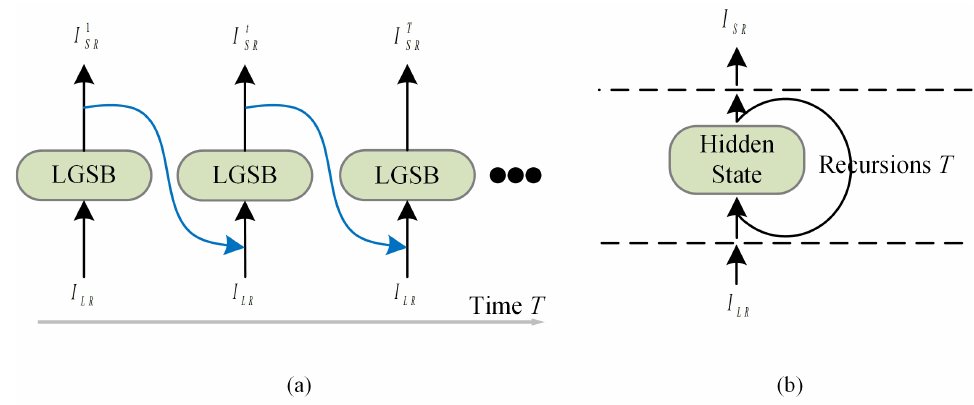
Figure 2. ( a ) The illustration of the Feedback Structure (FS) in the proposed FRLGN network and the blue arrow is the feedback connection. ( b ) The architecture of Traditional Recurrent